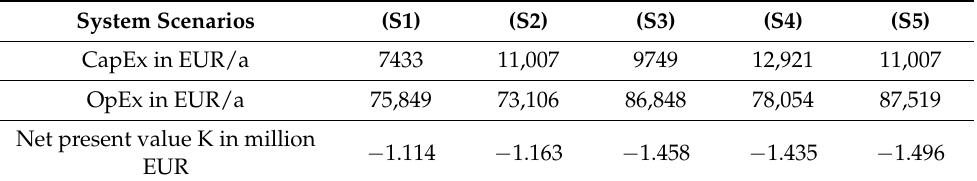
Table 5. Overview of the economic results of the considered system scenarios S1 to S5 in the building